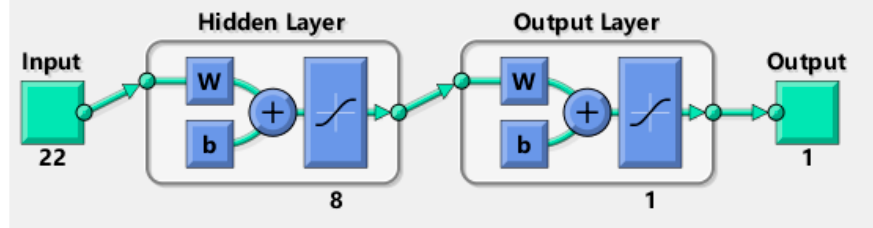
Figure 3. Neural network